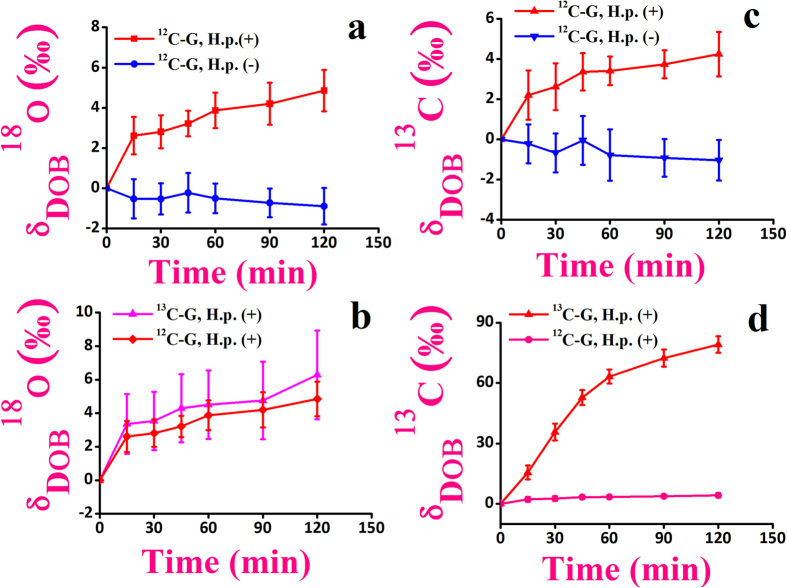
Excretion kinetics of δDOB
18O‰ and δDOB
13C‰ values of exhaled breath CO2 during unlabelled glucose (12C-G) metabolism of H. pylori positive [H. p. (+)] and H. pylori negative [H. p. (−)] individuals.(a) The excretion kinetics illustrating the increased δDOB18O‰ values for H. pylori positive [H. p. (+)] patients. (b) depicts the similar excretion kinetics of δDOB18O‰ values with that of 13C-enriched glucose. (c,d) enhancement of δDOB13C‰ values for H. pylori positive [H. p. (+)] patients and comparisons with the 13C-enriched glucose. Values are means ± SE.